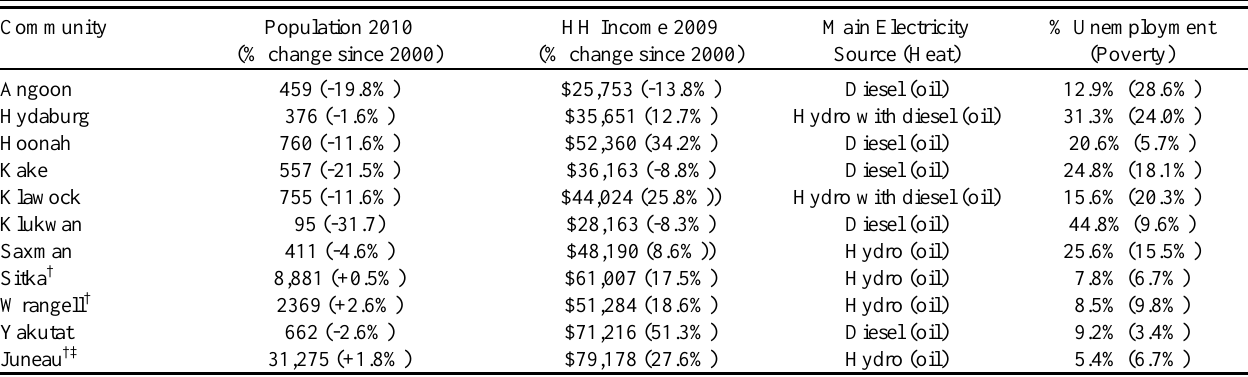
Table 1 . Southeast Alaska Native village population trends in relation to urban centers, household income, energy sources, and unemployment.